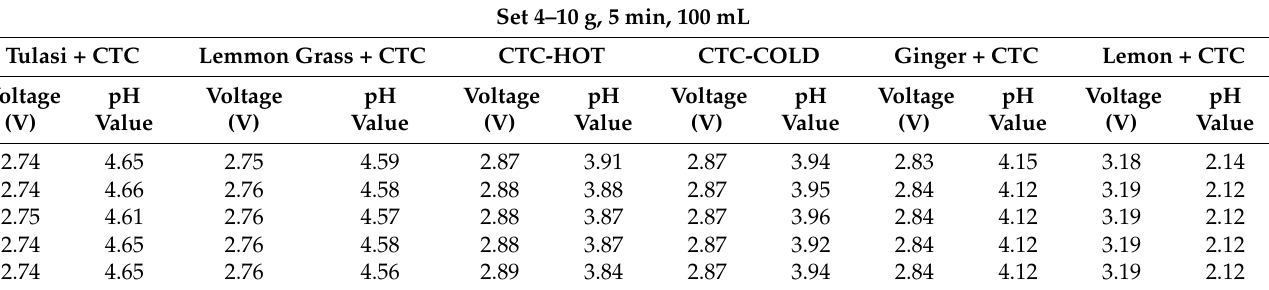
Figure 16. Tea infusion (Set 4–10 g, 5 min, 100 mL). Table 7. pH value and the corresponding port voltage for Set 4–10 g, 5 min, 100 mL.